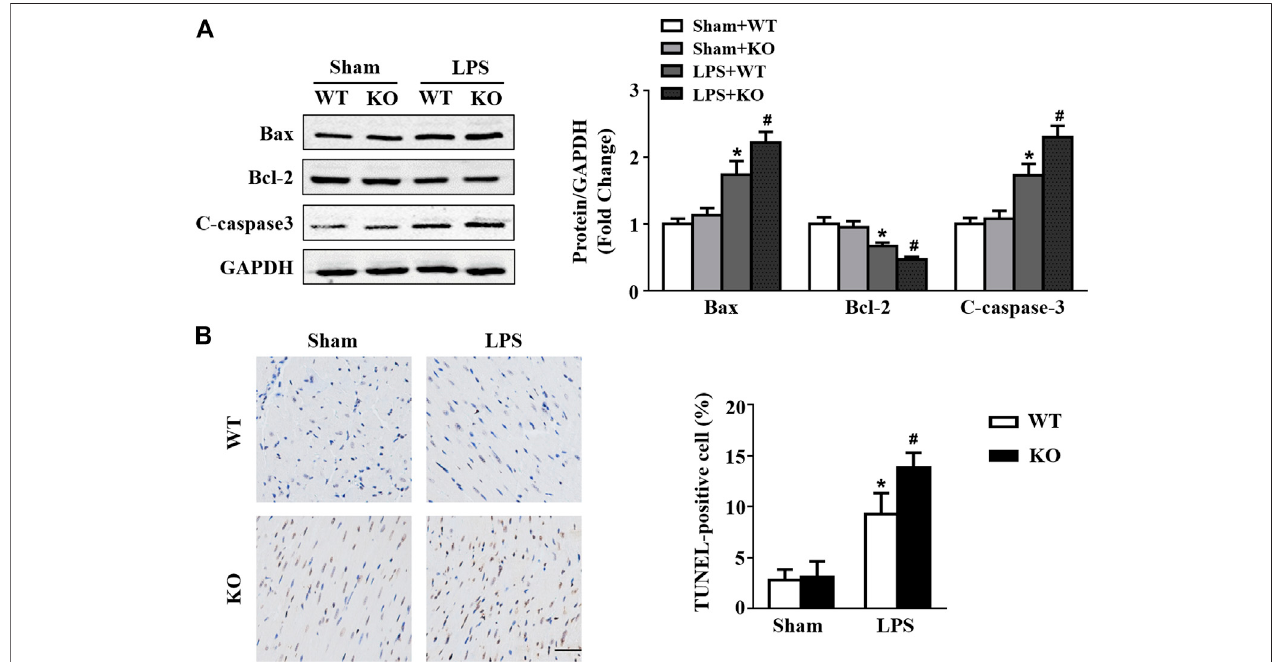
FIGURE6| Il12a deletionaggravatesLPS-inducedmyocardialapoptosis. (A) WesternblotanalysisofBax,Bcl-2andc-caspase-3proteinineachgroup(n (cid:1) 4). (C) TUNELstainingandthequantitative resultsofhearttissuesineachgroup(n (cid:1) 4;scalebar,50 μ m).* p < 0.05compared withthesham+WTgroup;# p < 0.05compared with the LPS + WT group.